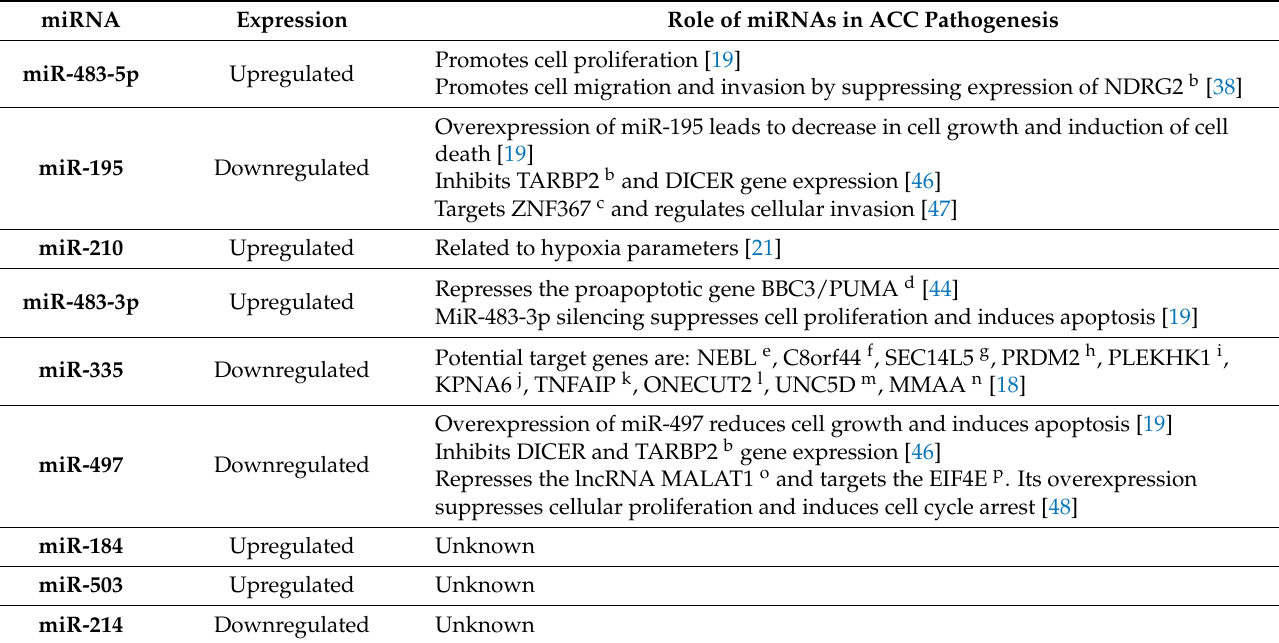
Table 5. miRNAs most frequently dysregulated in ACC compared to NAC or